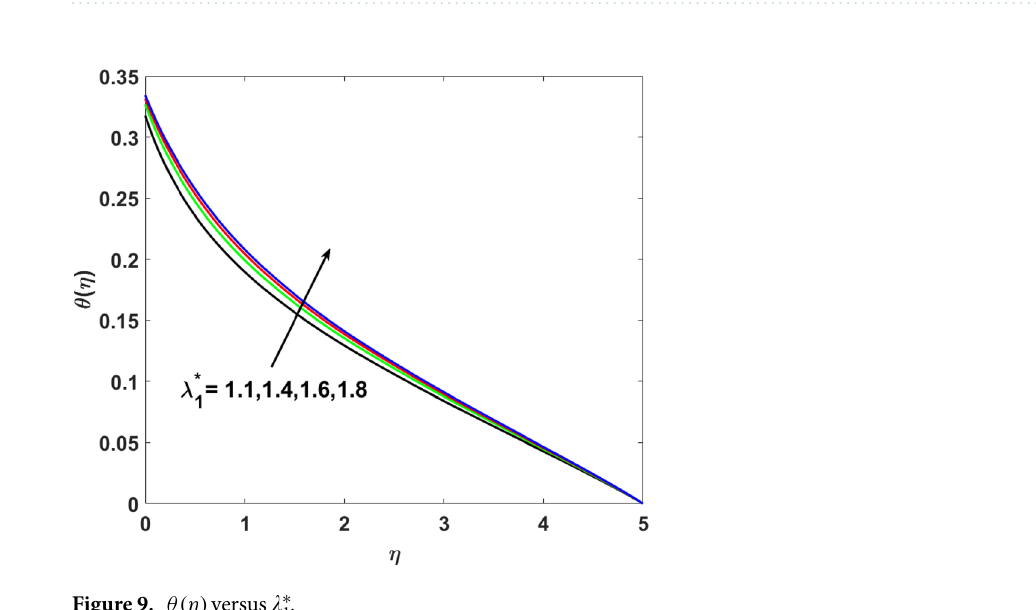
Figure 9. θ(η) versus (cid:31) ∗ 1